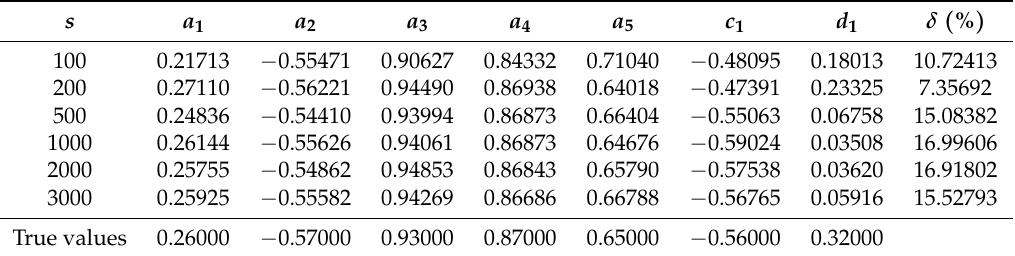
Table 1. The RGELS estimates and their errors.